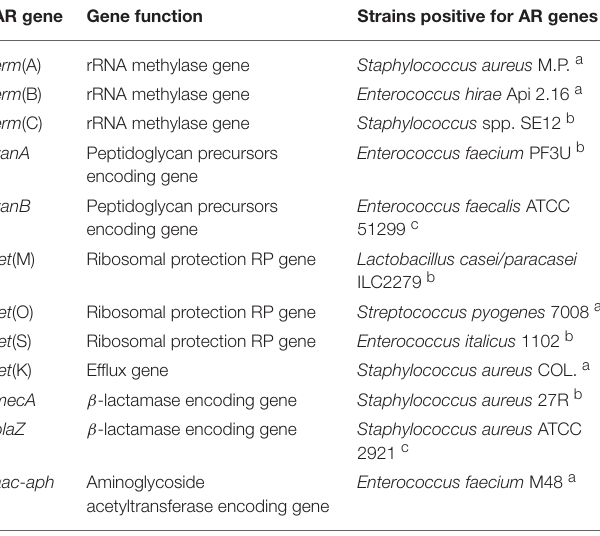
TABLE 2 | List of the 64 antibiotics determined in wheatmeal and carrots used as feed.